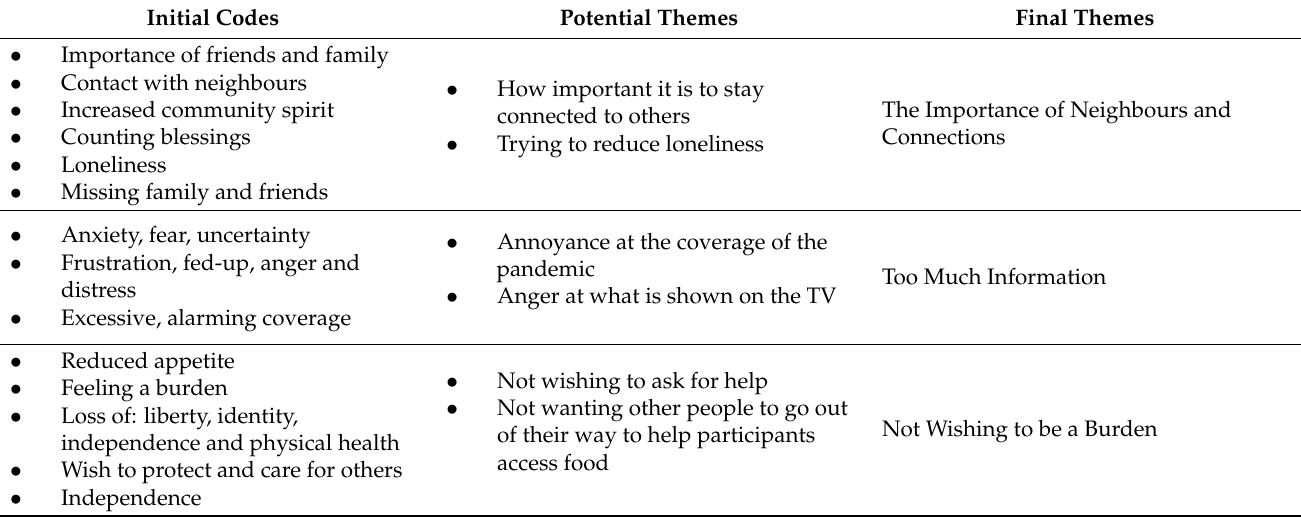
Table A1. Outline of the development of the final themes with examples of transcription and initial notes/codes/themes